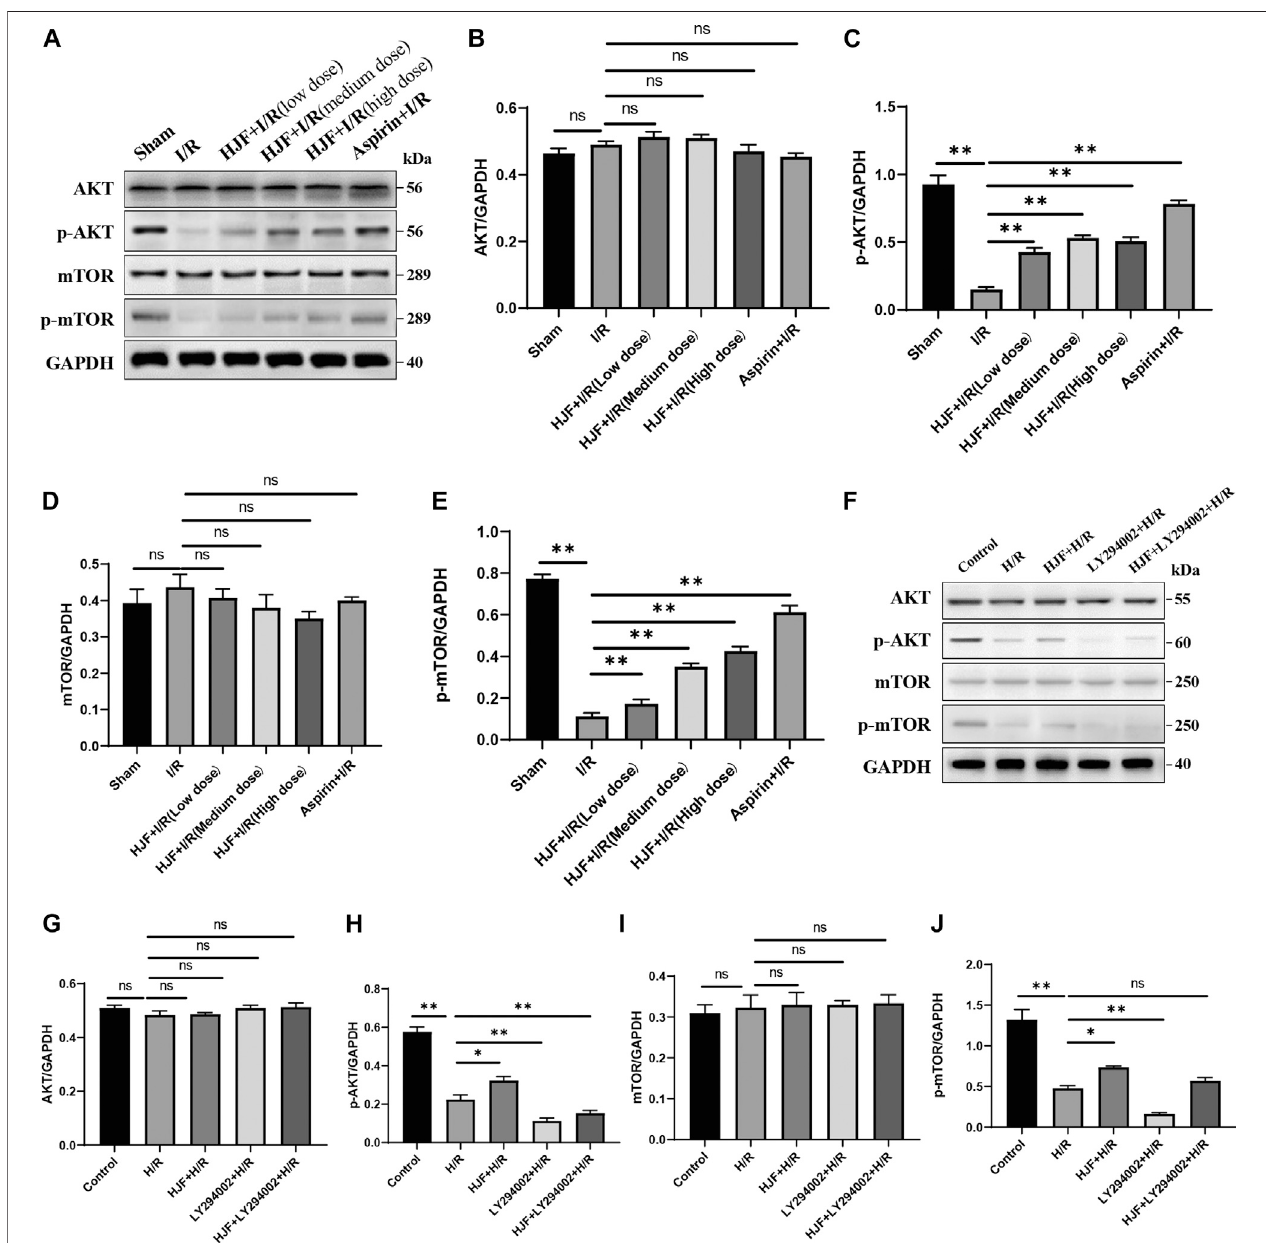
FIGURE7| EffectsofHJFonthePI3K/AKT/mTORsignallingpathway. (A) ,RepresentativewesternblotimagesofAKTandmTORinrats; (B) ,Quanti fi cationofthe levels of AKT in rat hearts; (C) , Quanti fi cation of the levels of p -AKT in rat hearts; (D) , Quanti fi cation of the levels of mTOR in rat hearts; (E) , Quanti fi cation of the levels of p -mTOR in rat hearts; (F) , Representative western blot images ofAKT and mTOR in H9C2 cells; (G) , Quanti fi cation of the levels ofAKT in H9C2 cells; (H) , Quanti fi cation of the levels of p -AKT in H9C2 cells; (I) , Quanti fi cation of the levels of mTOR in H9C2 cells; (J) , Quanti fi cation of the levels of p -mTOR in H9C2 cells. The data are shown as the means ± SDs in each group (n (cid:1) 3). * p < 0.05, ** p < 0.01. I/R, ischaemia/reperfusion; H/R, hypoxia/reoxygenation; HJF, Huoxue Jiedu